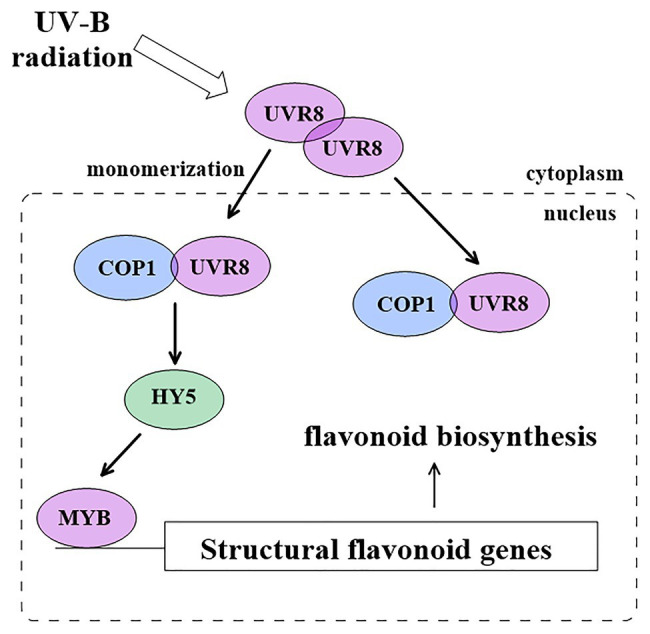
Proposed mechanism for UV-B signaling pathway in flavonoid biosynthesis.